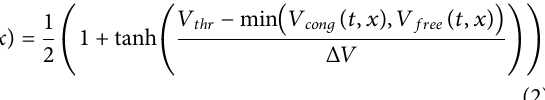
( Figure 1 ) in the northbound direction during severe traf fi c congestion. The markers depict the positions of the loop detectors and Bluetooth receivers, respectively. FCD are